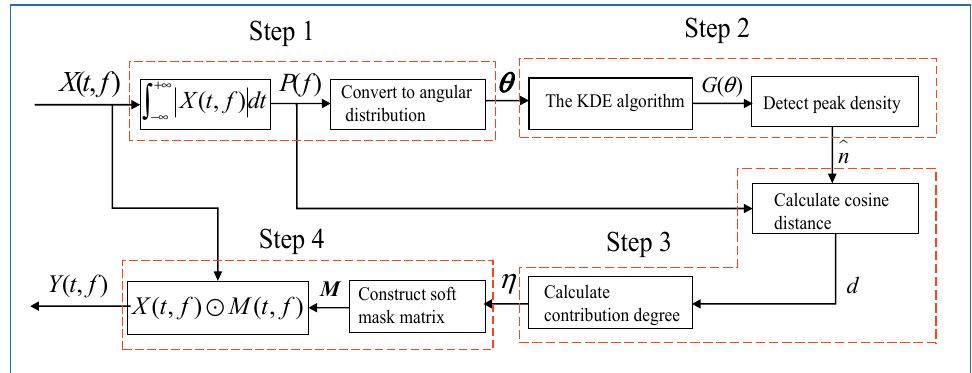
Figure 7. The flowchart of the proposed method.